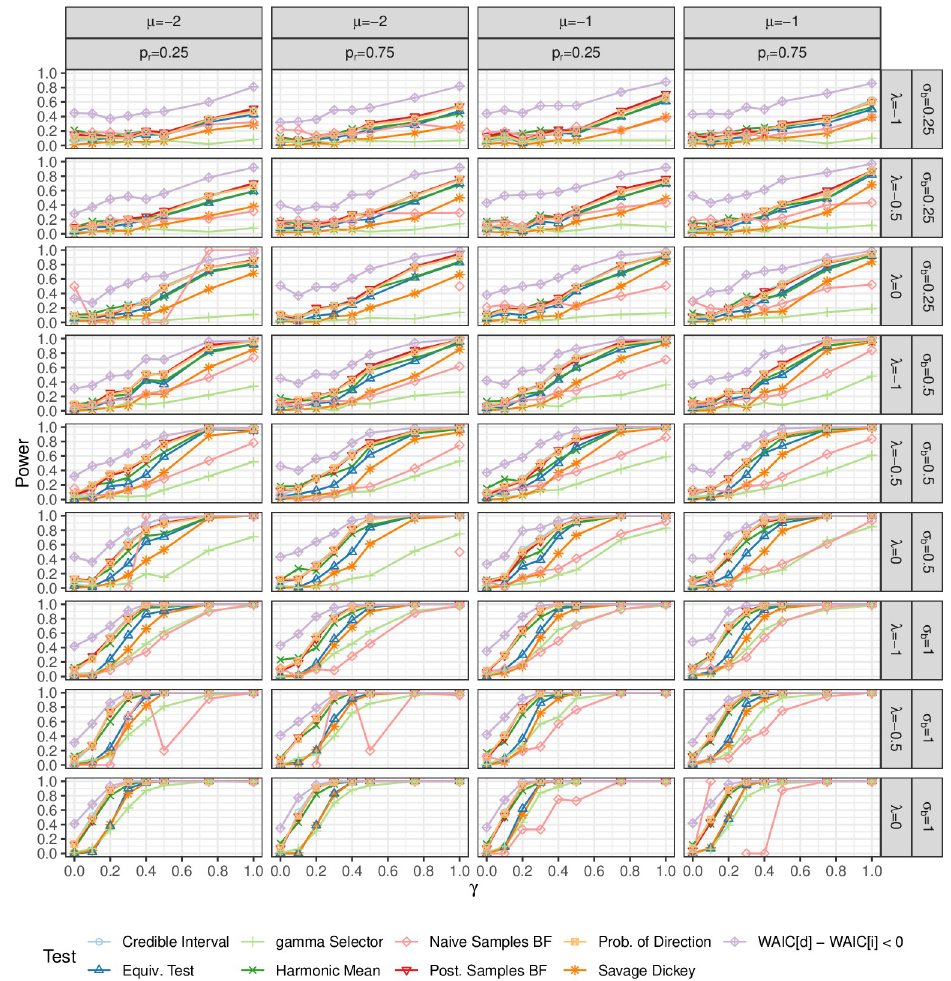
Fig 9. Results of the power study. The credible interval test and the Bayes factors that relied on posterior samples performed the best overall. Simply looking at whether the WAIC is smaller has high power at the expense of high type 1 error. The Savage Dickey representation of the BF might have higher power with better prior distributions. Using the variable selection method on γ has very low power, likely because γ is the coefficient of a latent variable rather than an observed covariate. The equivalence test and probability of direction have slightly lower power than simply checking the credible interval.